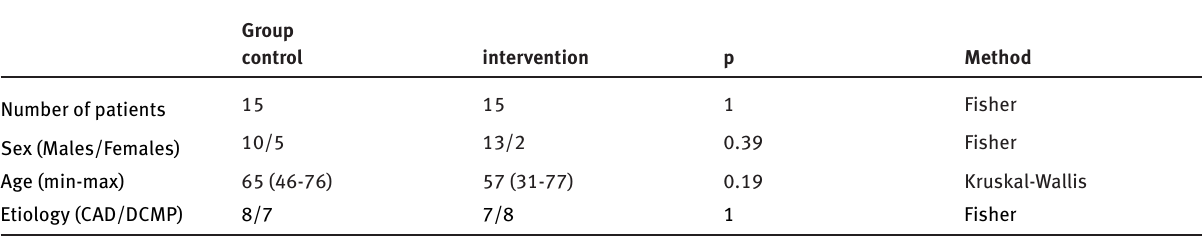
Table 1: Comparison of the treatment and control groups